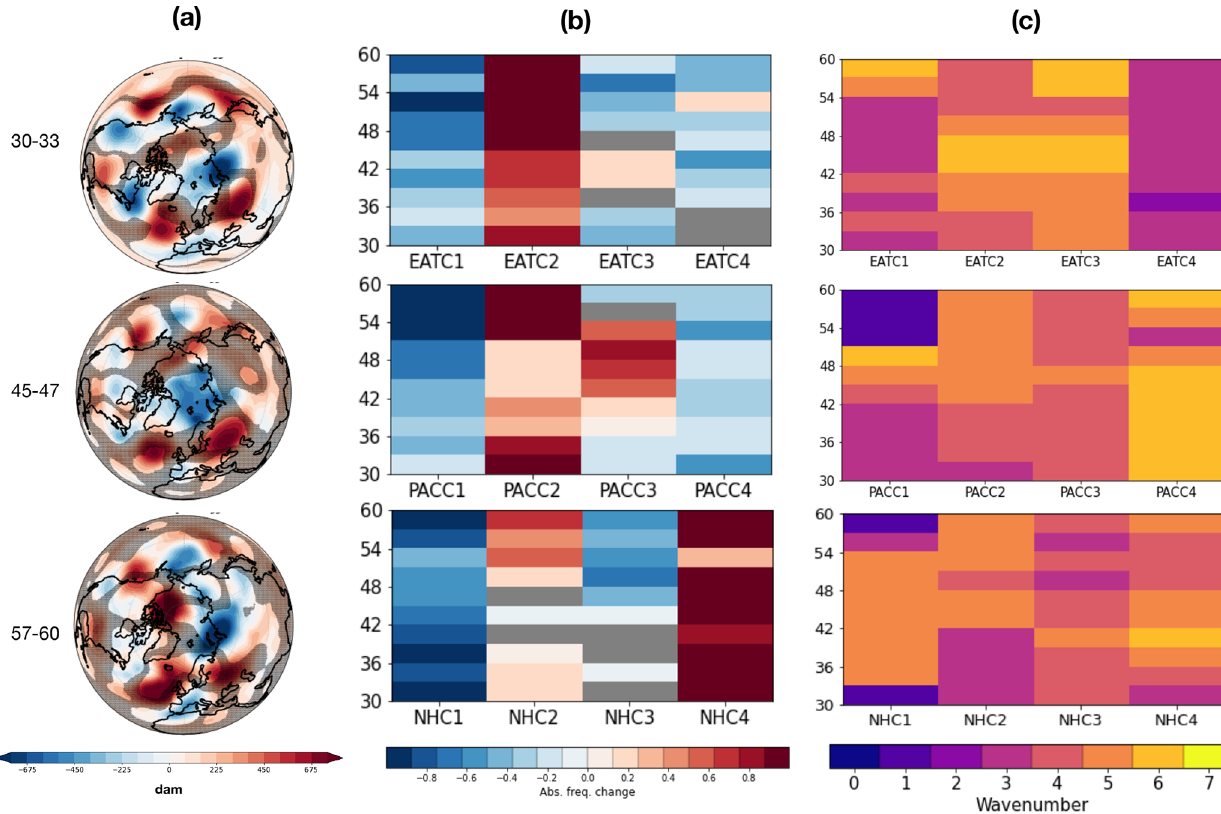
Figure 13. (a) Same as in Fig. 11, for 2010 poleward extremes only. The extremes are computed with respect to a detrended JJA mean in the 1979–2012 period. (b) Same as in Fig. 8, for 2010 poleward extremes only. (c) Same as in Fig. 10, for 2010 poleward extremes